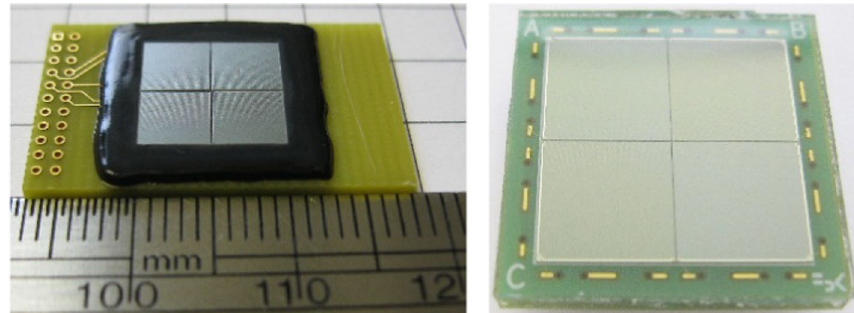
Fig. 10 Photographs of 2 2 PS-SiPM arrays from (left) Radiation Monitoring Devices, Inc. (RMD) [140, 143] × and (right) Fondazione Bruno Kessler (FBK)